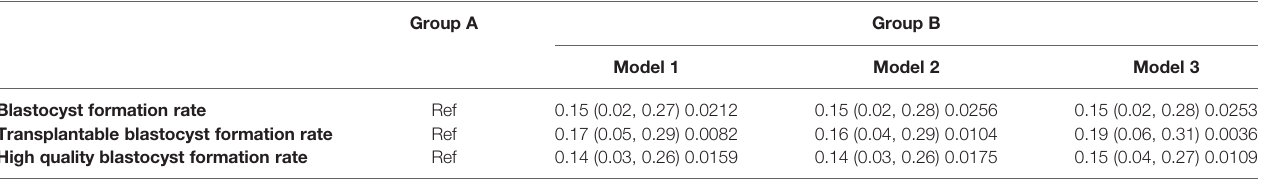
The data in the table: effect size (95% CI) p value. Unadjusted model (model 1), minimum-adjusted model (model 2), fully-adjusted model (model 3). Adjusted factors: Female ’ s age (y); basal serum AMH (mIU/ml); BMI (kg/cm3); no. of retrieved oocytes; fertilization rate. Group A: control group, means that there are no grade IV embryos; group B means that there are polypronuclear embryos in the WOW-based TLS system.